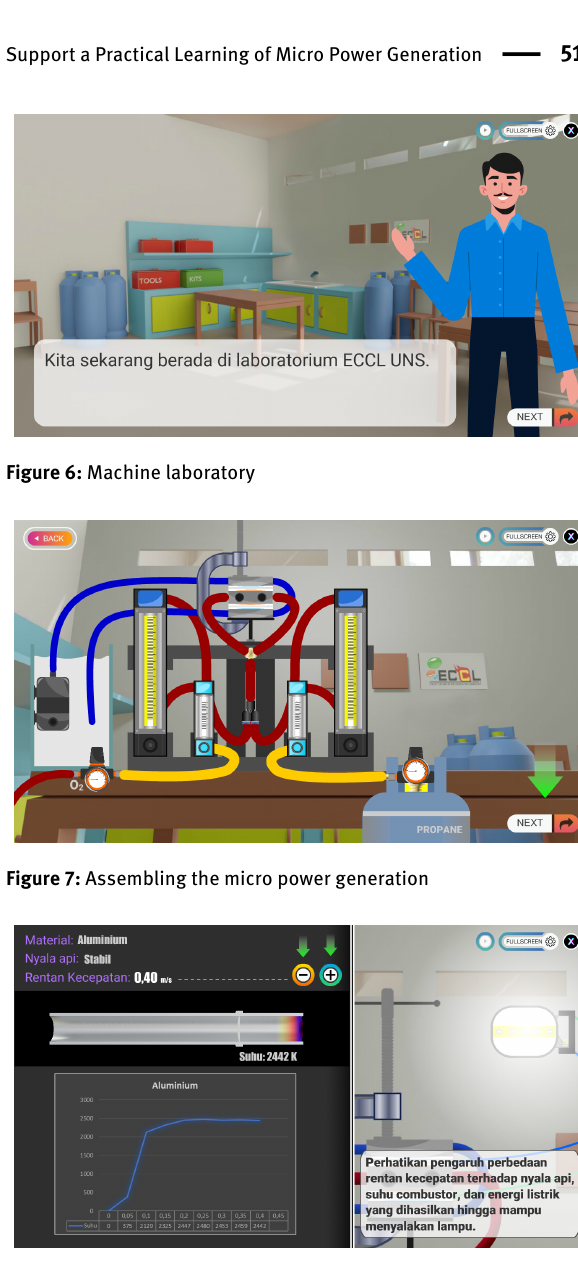
Figure 8: Display simulation in the virtual laboratory